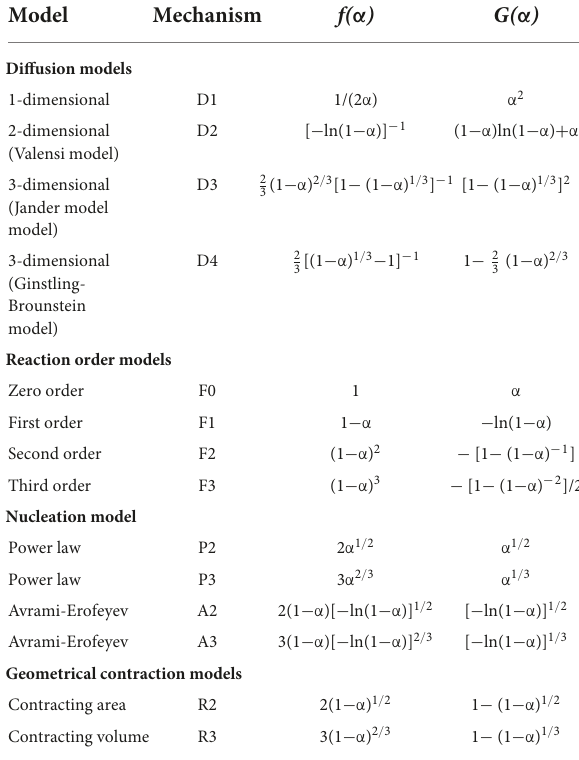
Figure 1 shows the pyrolysis characteristics of RH, PW, SUG, and PP at 10 ◦ C/min, which exhibit significant differences. The initial decomposition temperature of PP was 340 ◦ C, and the pyrolysis was completed at 480 ◦ C. However, the pyrolysis temperature of biomass materials was generally low, because PP is more stable than biomass and PP requires a higher pyrolysis temperature (Burra and Gupta, 2018). The initial devolatilization temperatures of RH, PW, and SUG were 230, 200, and 190 ◦ C, respectively. The pyrolysis of RH, PW, and SUG TABLE 3 Algebraic expression of different models for solid-state heterogeneous reactions. Model Mechanism f( α ) G( α ) Diffusion